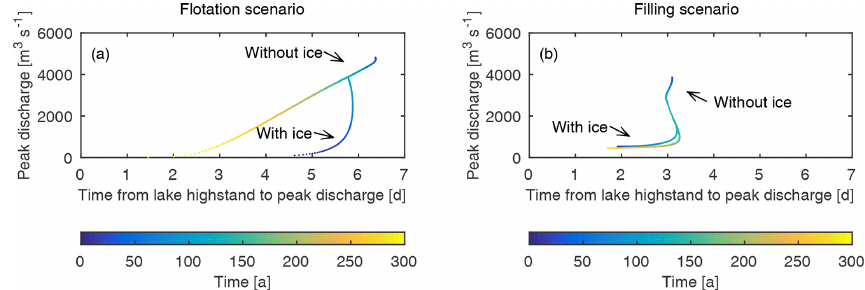
Figure 11. Comparison of peak discharge and time from lake highstand to peak discharge for the box-shaped basin under the (a) flotation and (b) filling